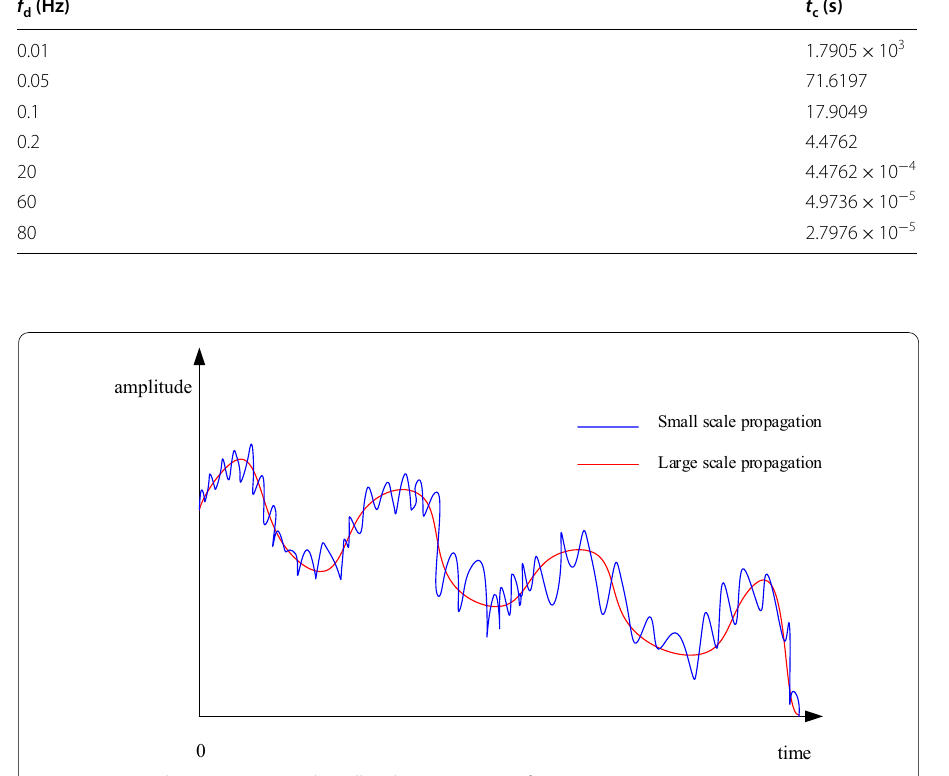
Fig. 4 Large scale propagation and small scale propagation of MIMO-OFDM